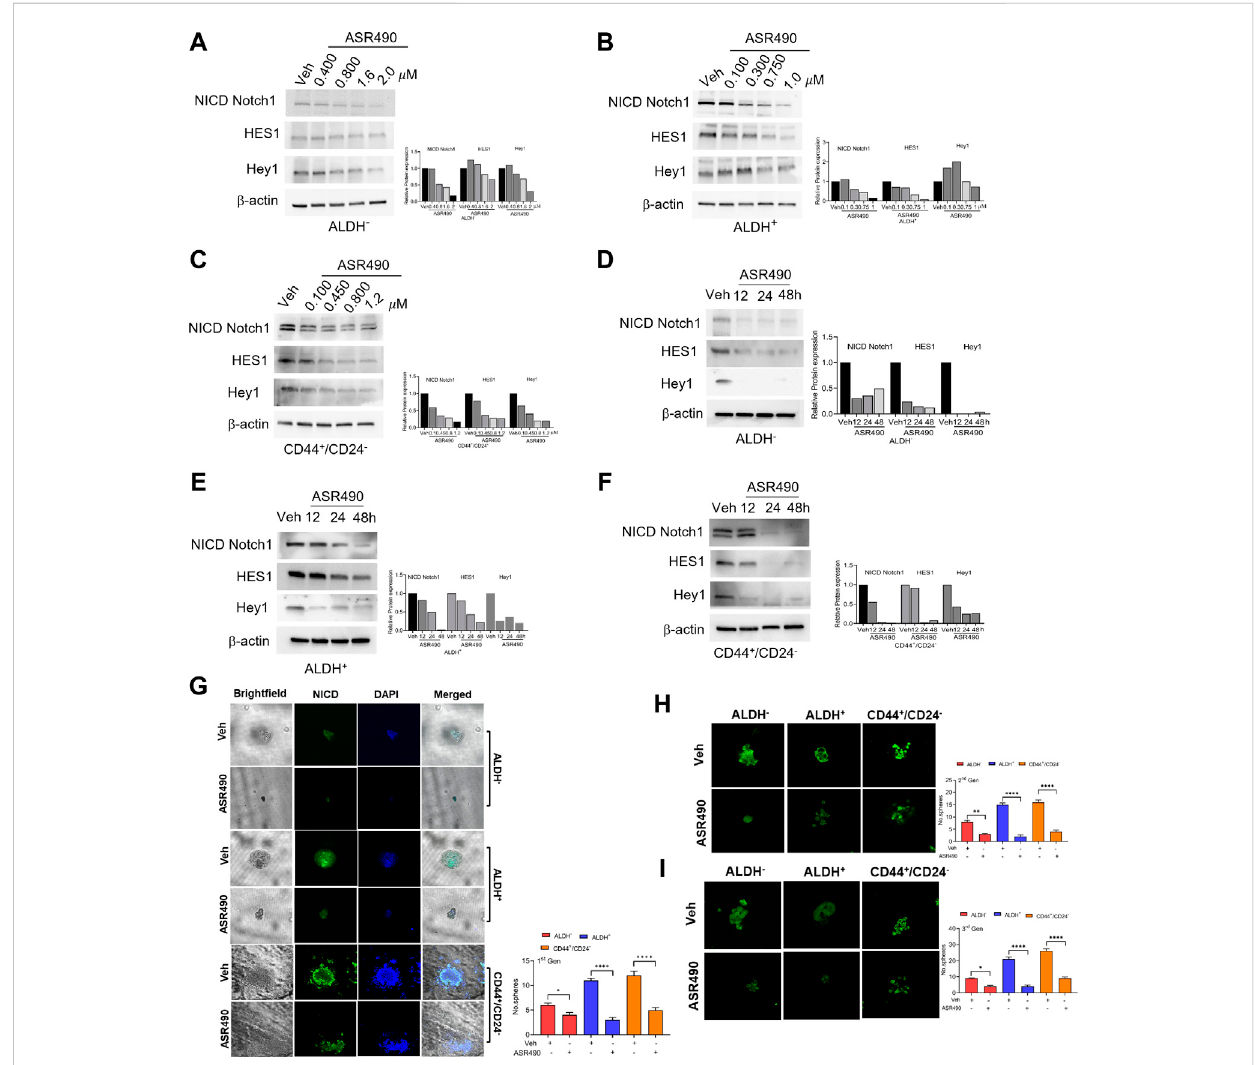
FIGURE 2 ASR490 mediates its effect by speci fi cally inhibiting Notch1-NICD signaling and self-renewal capacity. (A – F) Western blots for Notch1-NICD (the active form of Notch1), HES1, and Hey1 expression to assess the dose- (A – C) and time-dependent (D – F) effects of ASR490 on ALDH − , ALDH + , and CD44 + /CD24 − cells. (G) Representative bright fi eld and immuno fl uorescent images of Notch1-NICD (active form of Notch1) expression in vehicle and ASR490-treated fi rst-generation mammospheresofALDH − ,ALDH + and CD44 + /CD24 − cells. Thenumberofspheroidspergroup andcelltypewere quanti fi ed and presented graphically ( n = 4, * p < 0.02 and **** p < 0.0001). (H) Immuno fl uorescent images of Notch1-NICD expression and number of spheroids quanti fi ed for second generation of serially passaged fi rst-generation vehicle and ASR490-treated ALDH − , ALDH + , and CD44 + /CD24 − mammospheres ( n = 4, ** p < 0.007 and **** p < 0.0001), (I) Third generation of serially passaged second-generation spheroids. ( n = 4, *, p < 0.02 and ****, p < 0.0001). Second and third-generation cells were not subjected to ASR490 treatment. p values are based on one-way ANOVA with post hoc Dunnett ’ s